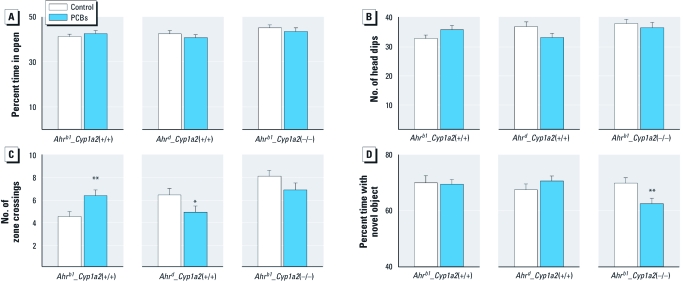
Results of elevated zero maze (5 min). (A) Percent time in open. (B) Number of head dips. (C) Number of zone crossings. (D) Percent time exploring novel object. Data shown are least-squares mean ± SE. *p < 0.05, and **p < 0.01, compared with untreated controls of the same genotype.